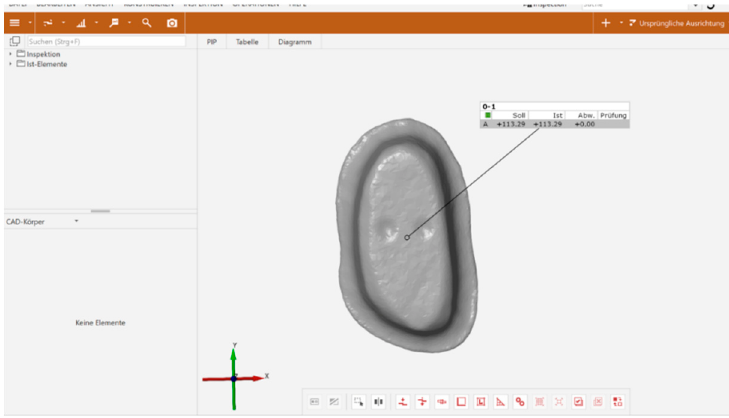
Figure 5. Surface calculation in mm² using GOM 3D analysis software.